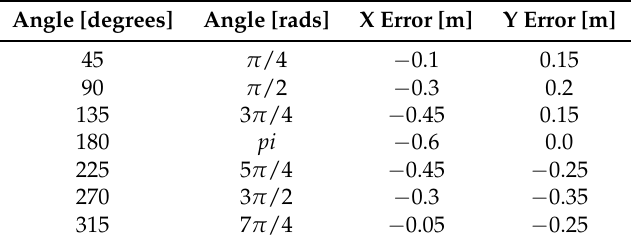
Table 9. Visual odometry systems, mean error measurements.